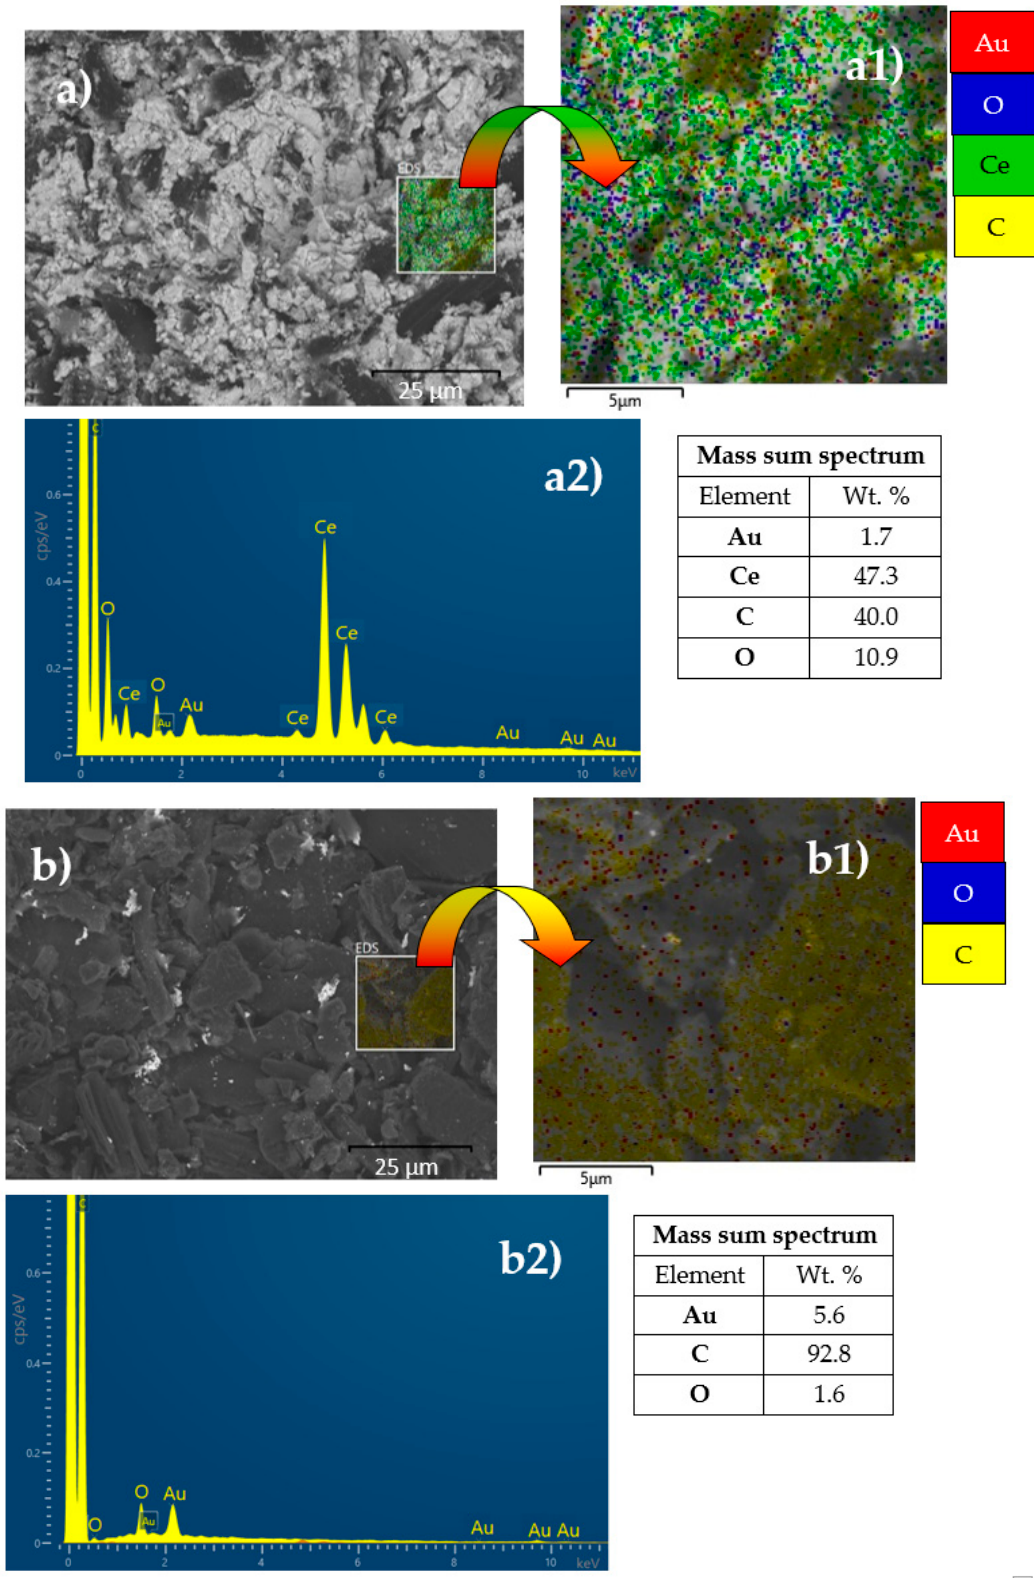
Figure 2. SEM images of the AuCeO 2 /C ( a ) and Au/C ( b ) catalysts, enlarged images of the EDS area ( a1 , b1 ), and total spectra of elements ( a2 , b2 ).